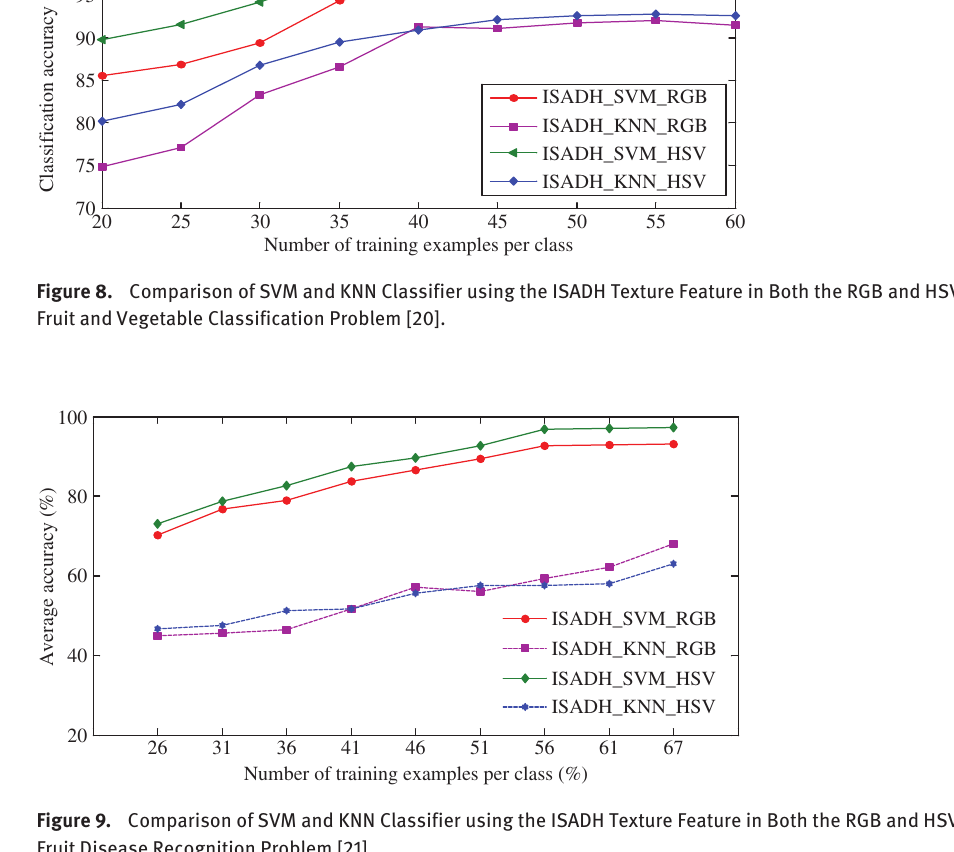
Figure 9. Comparison of SVM and KNN Classifier using the ISADH Texture Feature in Both the RGB and HSV Color Spaces for Fruit Disease Recognition Problem [21].